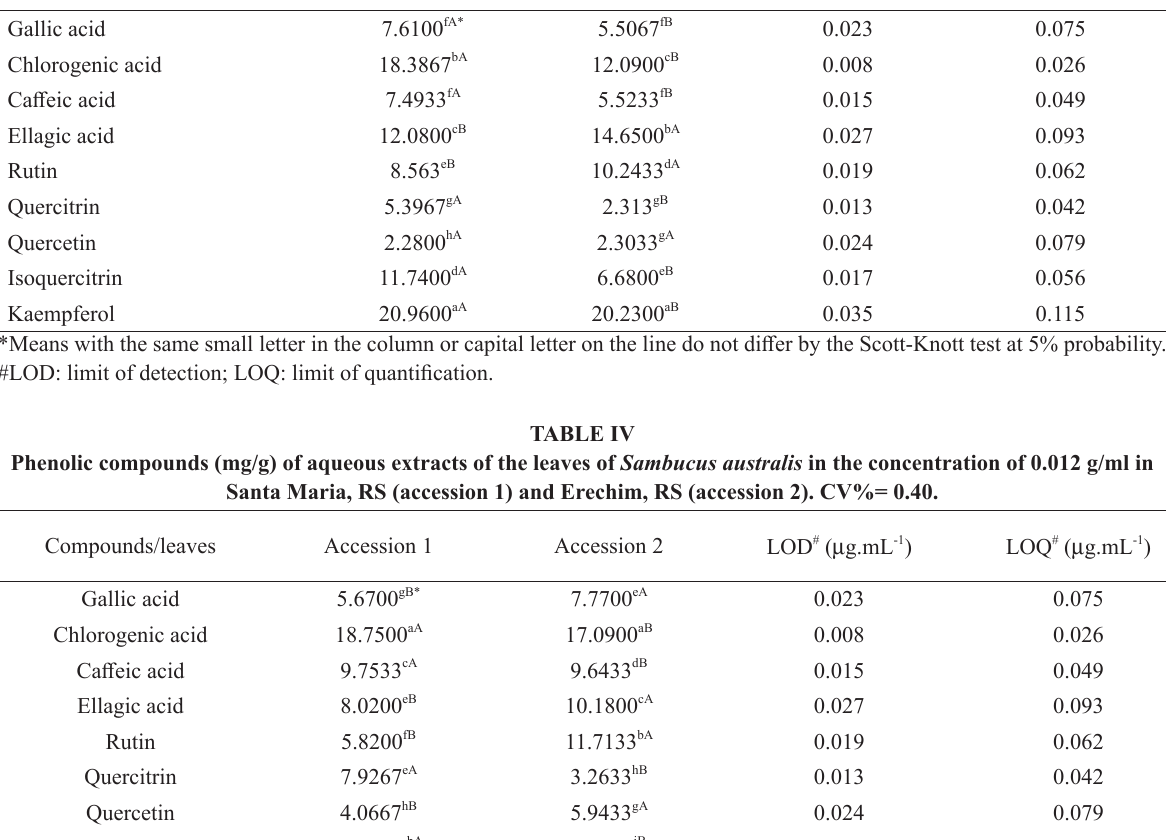
Phenolic compounds (mg/g) of aqueous extracts of the inflorescences of Sambucus australis in the concentration of 0.012 g/ ml in Santa Maria, RS (accession 1) and Erechim, RS (accession 2). CV%= 0.68. Compounds/infloresc.